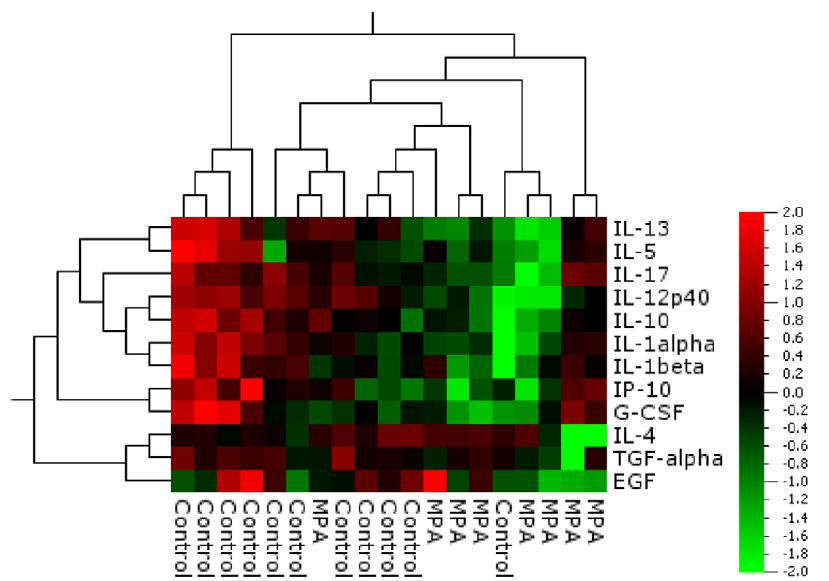
Figure 4. Differential expression of cytokines in supernatants of BCG stimulated PBMCs of MPA users and control participants three days post stimulation. In an unbiased analysis approach using the Qlucore Omics explorer software to generate a heat map, clustering of the participants based on cytokine expression levels coincided with the two study groups (Controls n=11 and MPA users n=8). Over-expressed cytokines are depicted in red and under-expressed cytokines in green.